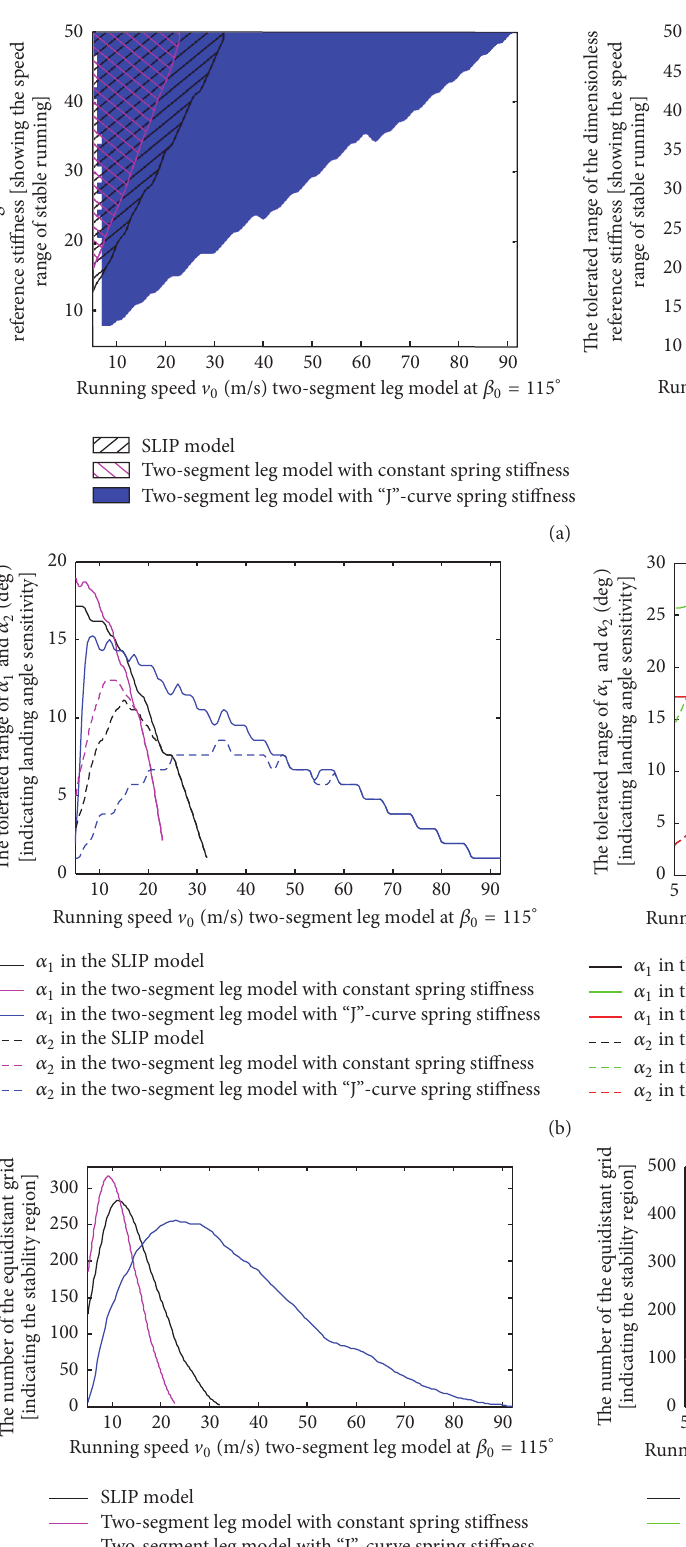
SLIP model Two-segment leg model with constant spring stiffness Two-segment leg model with “J”-curve spring stiffness